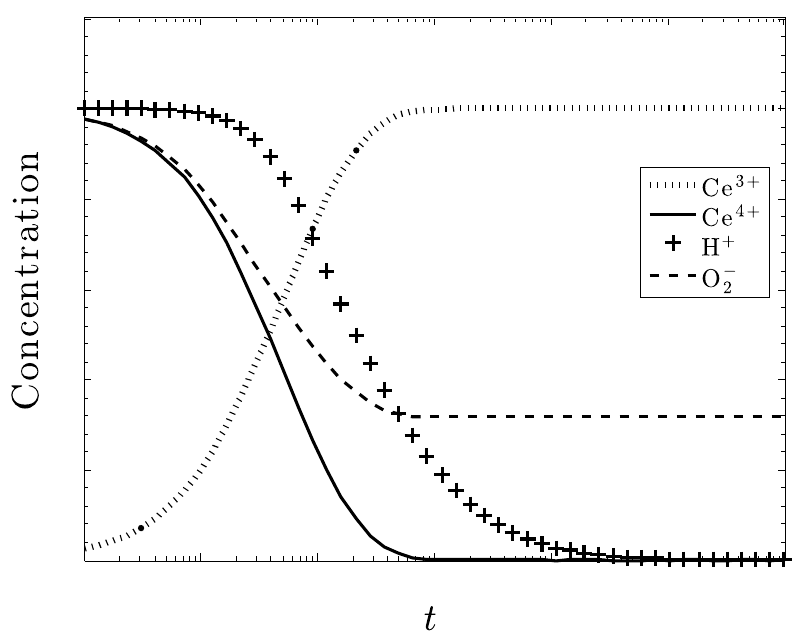
Figure 4. Now k 1 is fixed at five-times greater than k 2 , k 3 and k 4 . The other species concentrations are equal, and the system again starts out as CeO 2 .